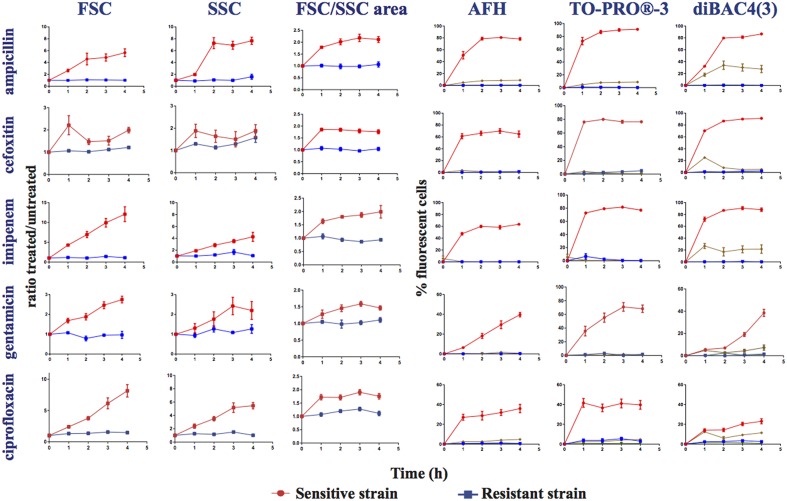
Monitoring alterations of the E. coli strains treated with different antibiotics via flow cytometry. Time course study of sensitive (ATCC25922 strain sensitive to all the studied antibiotics) and resistant strains treated, or not, with ampicillin, cefoxitin, imipenem, gentamicin, and ciprofloxacin. This figure shows the ratios of the mean FSC intensity of the antibiotic treated samples/the mean FSC intensity of the untreated samples; the ratios of the mean SSC intensity of the treated samples/the mean SSC intensity of the untreated samples; the ratios of the area of the density plots for FSC/SSC (FSC/SSC area) of the antibiotic-treated samples/the FSC/SSC area of the untreated samples; and the percentage of fluorescent cells stained with AFH, TO-PRO®-3 and DiBAC4(3) of the antibiotic-treated samples, all relative to incubation time. The percentage of fluorescent cells in treated samples was determined using the fluorescence of the untreated samples as a baseline. , sensitive antibiotic-treated strain, , resistant antibiotic-treated strain, , autofluorescence of the sensitive antibiotic-treated strain, , autofluorescence of the antibiotic-treated resistant strain (Ex 640 nm, Em 675 nm ± 25 nm for AFH and TO-PRO®-3; Ex 488 nm, Em 530 nm ± 30 nm for DiBAC4(3)). Each value represents the mean value obtained from four independent experiments. The error bars correspond to the standard error of the mean.